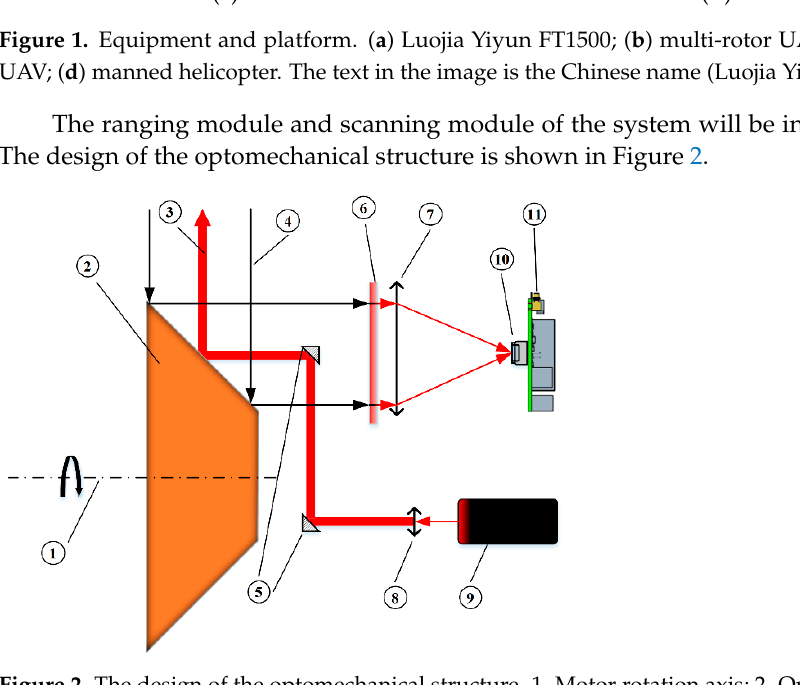
Figure 2. The design of the optomechanical structure. 1. Motor rotation axis; 2. Quadrangular tower mirror; 3. Emitted light; 4. Echo light; 5. Reflector; 6. Narrow band filters; 7. Aspheric focusing lens; 8. Collimating lens; 9. Laser; 10. Avalanche photodiode (APD); 11. Analog amplifier circuit.